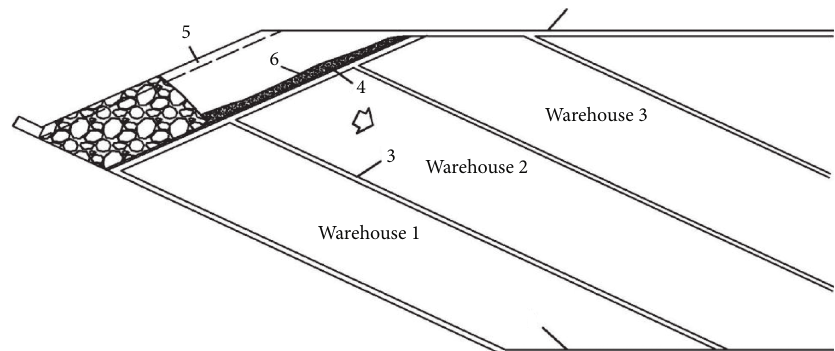
Figure 1: Roadway layout of sloping flexible shield support backfilling method. 1: main roadway; 2: main airway; 3: coal carrying slope; 4: working face; 5: open cut; and 6: gangue cushion.